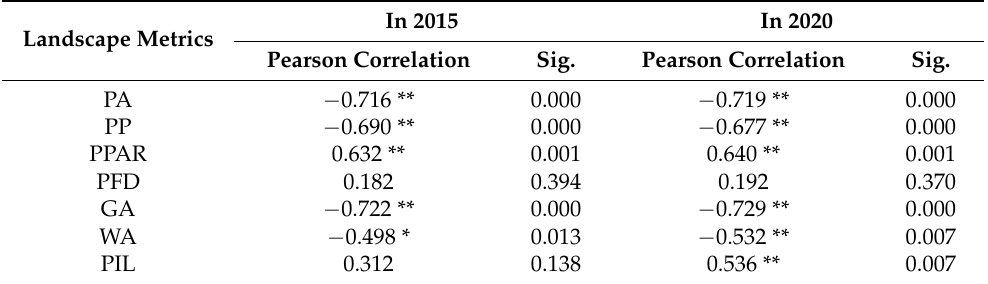
Table 4. Pearson correlation coefficients of park landscape metrics with mean LST within the parks. Landscape Metrics